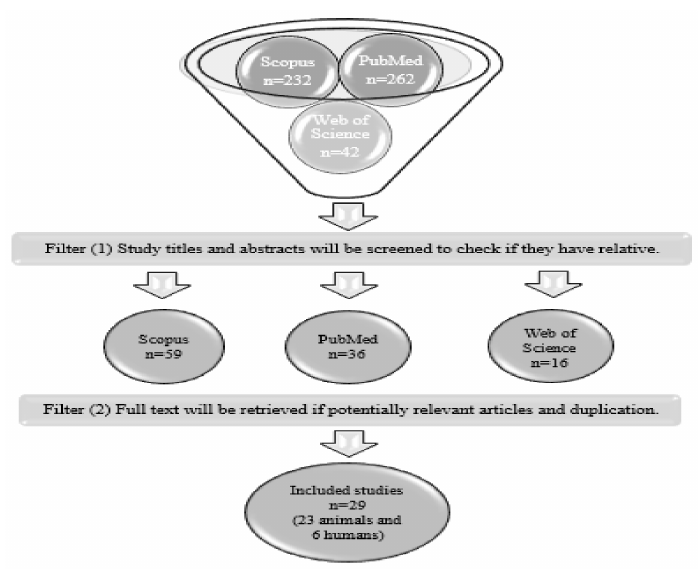
Figure 1. Study search strategy.